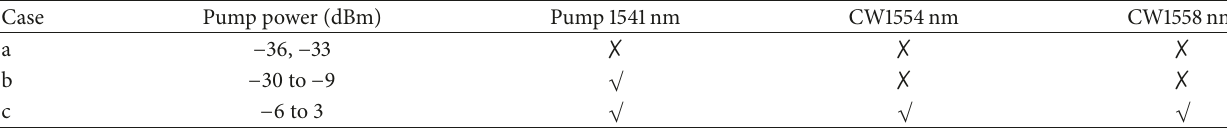
Table 1: Pump power classification for proposed